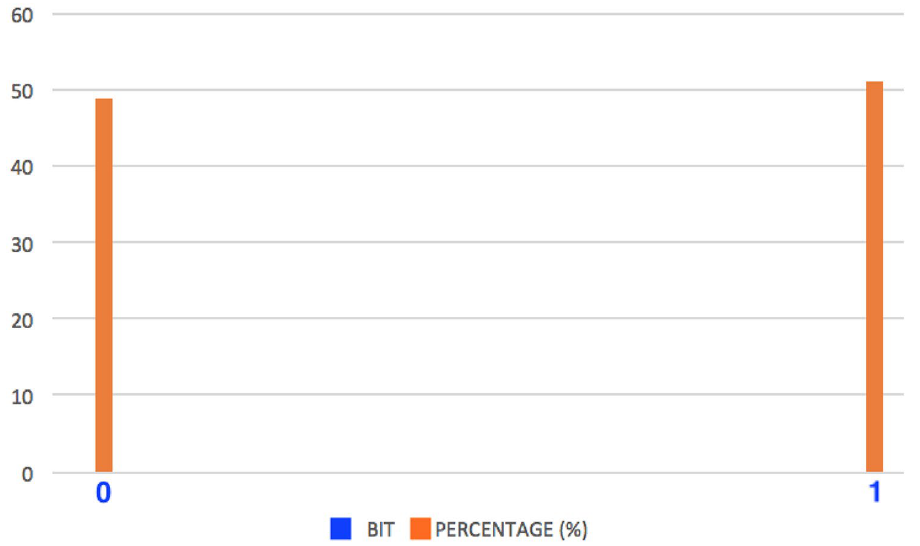
Figure 8. Probability of output logic ‘0’ and ‘1’ are near 50% (49% and 51% for logic ‘0’ and logic ‘1’